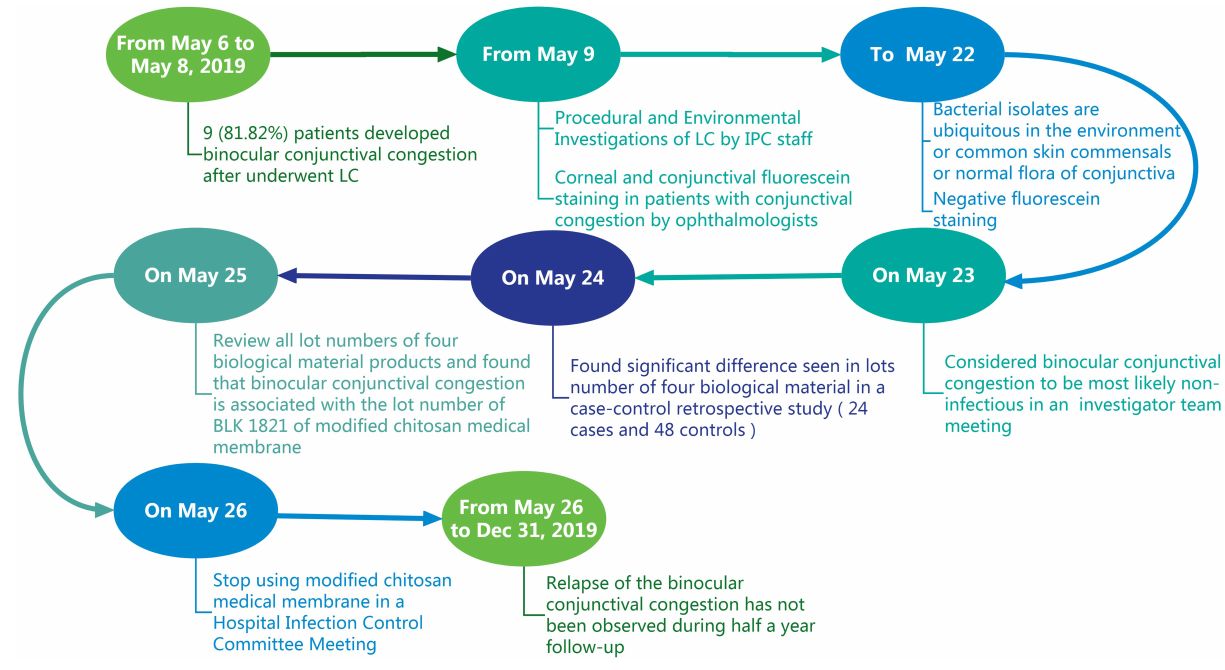
laparoscopes (post-sterilization), operating room (OR) air,